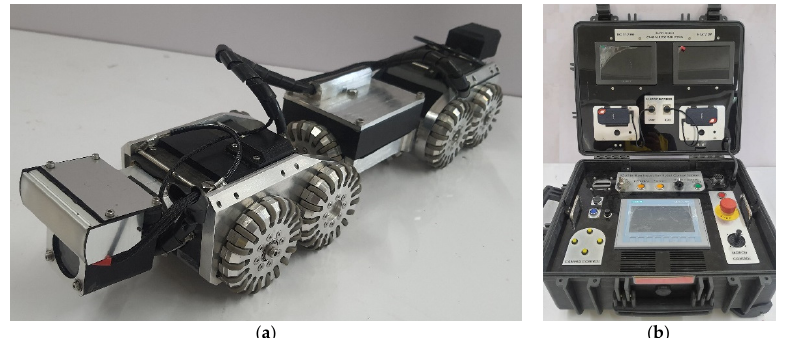
Figure 13. ( a ) The prototype of the developed in-pipe inspection robot; ( b ) the camera display panel and the robot’s control panel. Table 3. The specifications of the prototype of the developed robot.